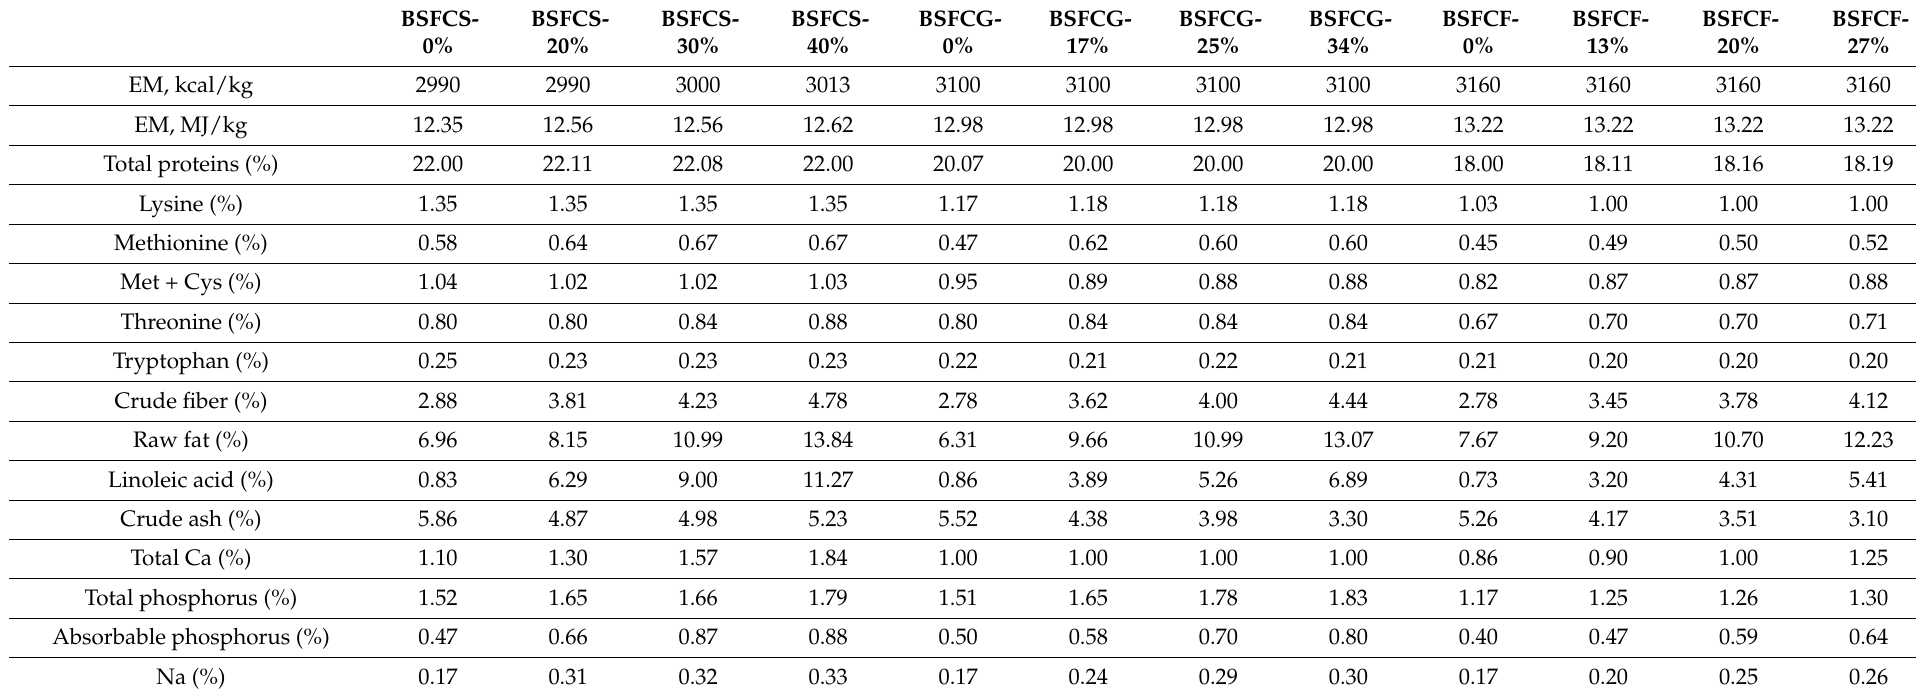
Table 6. Nutritional composition of feed compounds with and without the addition of black soldier fly